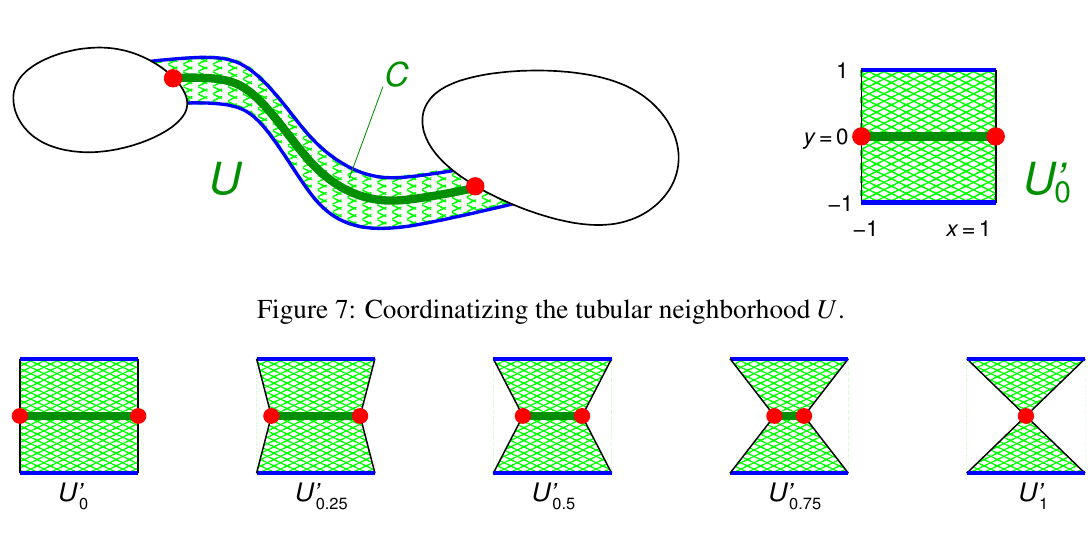
Figure 8: The sets U (cid:48) . Note that the top and bottom parts of the boundary are constant for all t . t